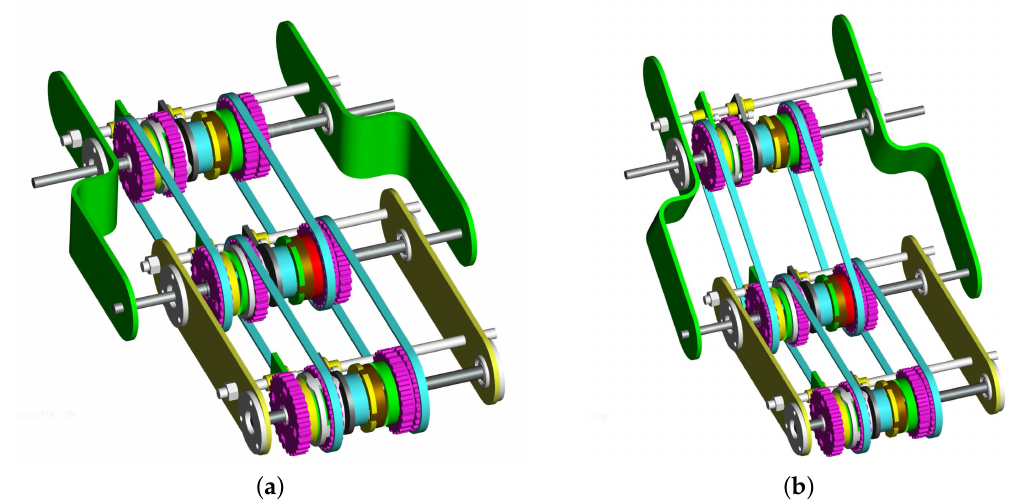
Figure 11. The Joint 2 drives the Arm 2 to rotate for δ 1 . ( a ) The Joint 2 is in switched on status. ( b ) The Joint 2 is after having been driven for δ 1